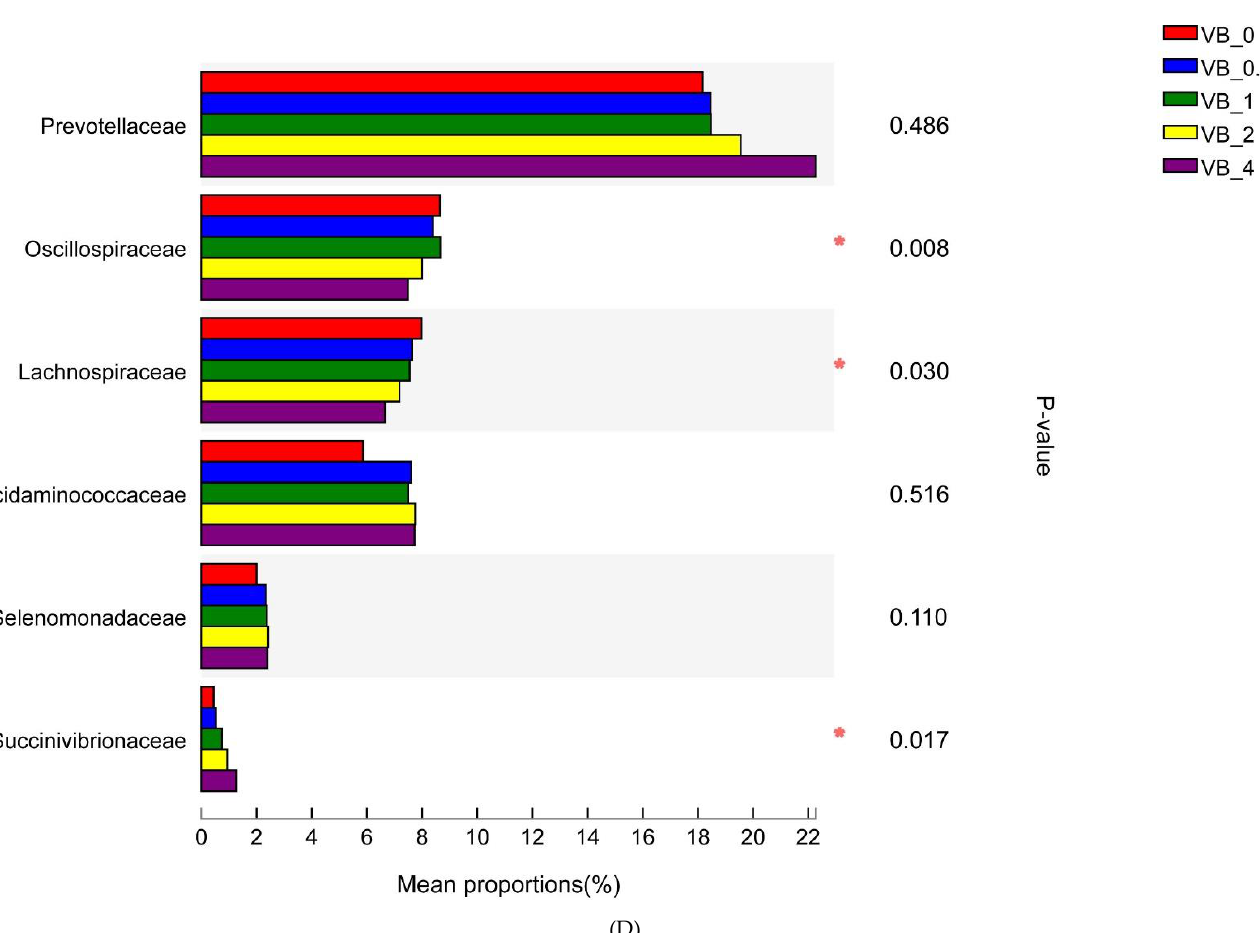
Figure 2. Changes in the bacterial community structure in the rumen fermentation system with increasing vitamin B 12 supplementation: at the phylum level ( A ), at the class level ( B ), at the order level ( C ), at the family level ( D ). (* P < 0.05)